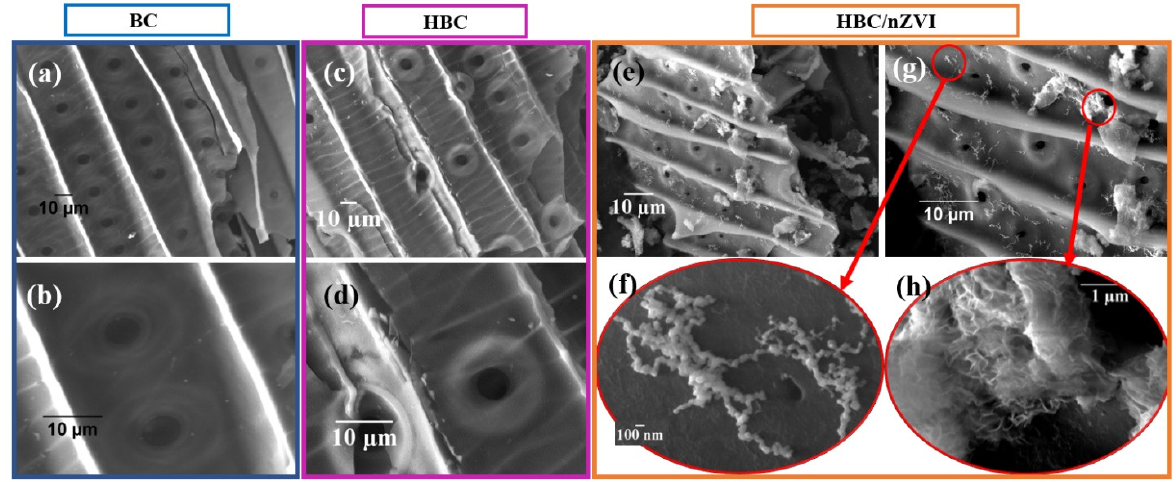
Figure 1. Surface morphology of ( a , b ) virgin BC, ( c , d ) HBC, and ( e – h ) HBC/nZVI.